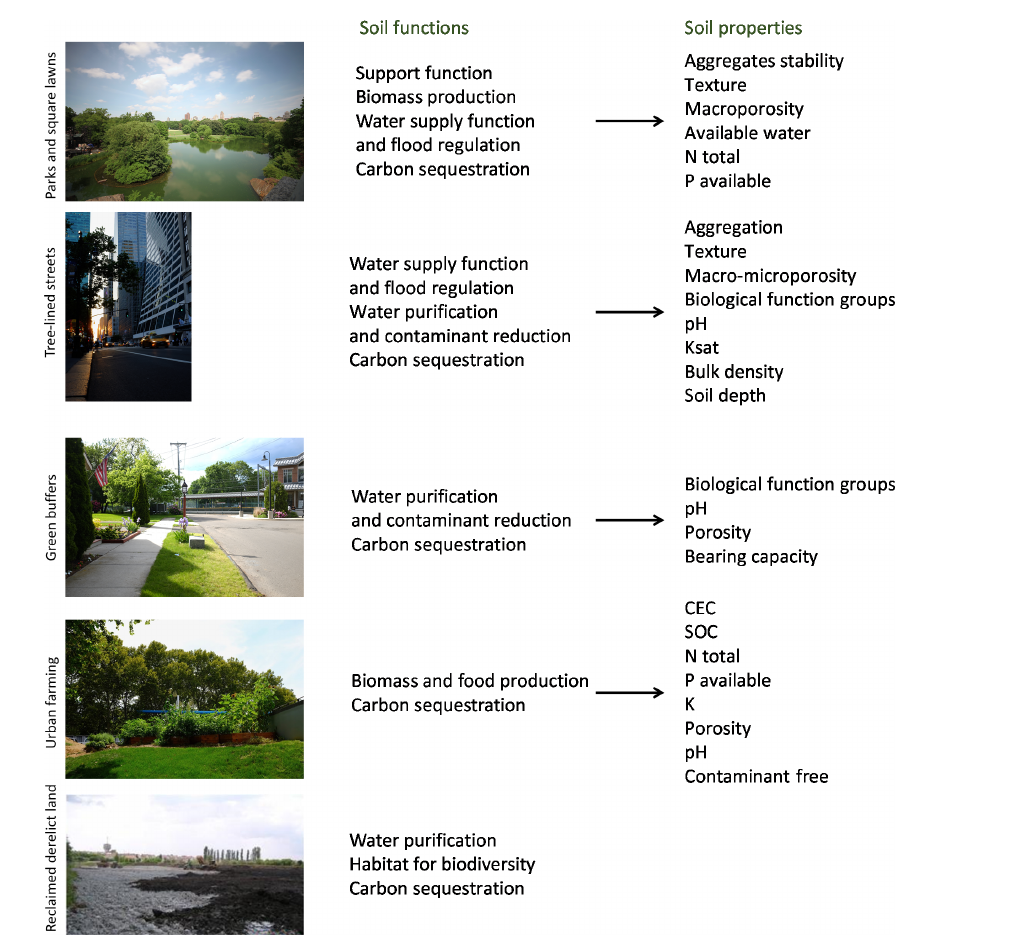
Figure 2. Soil properties to be considered for fulfilling soil functions provided by constructed Technosols in different land